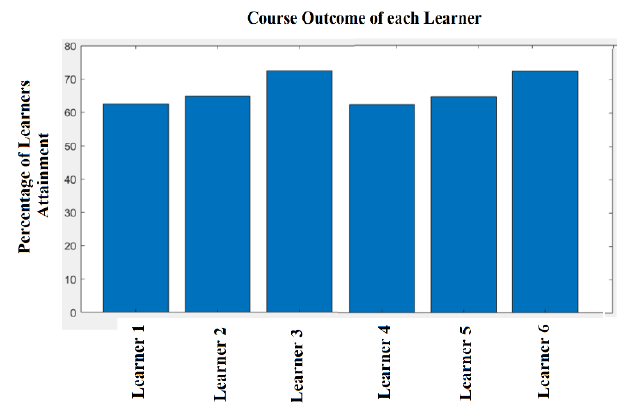
Figure 13. Each learner performance at end of the course